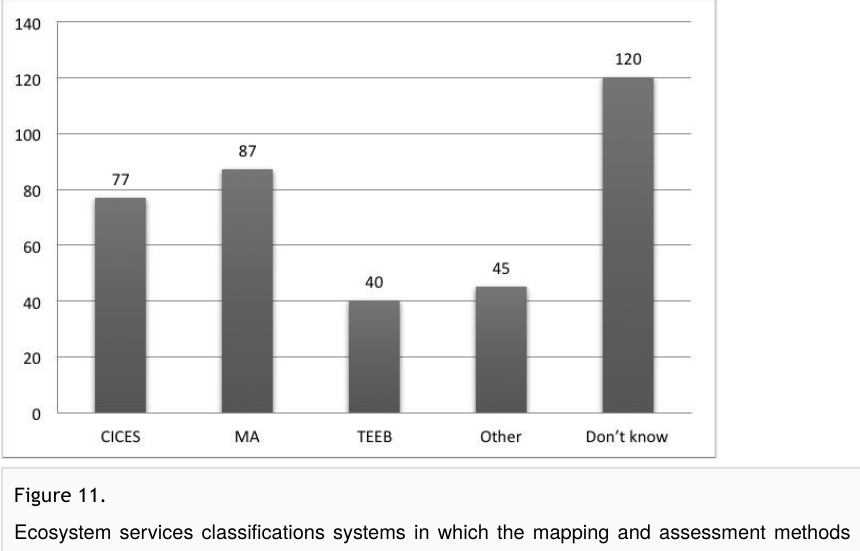
Figure 11. Ecosystem services classi fi cations systems in which the mapping and assessment methods were